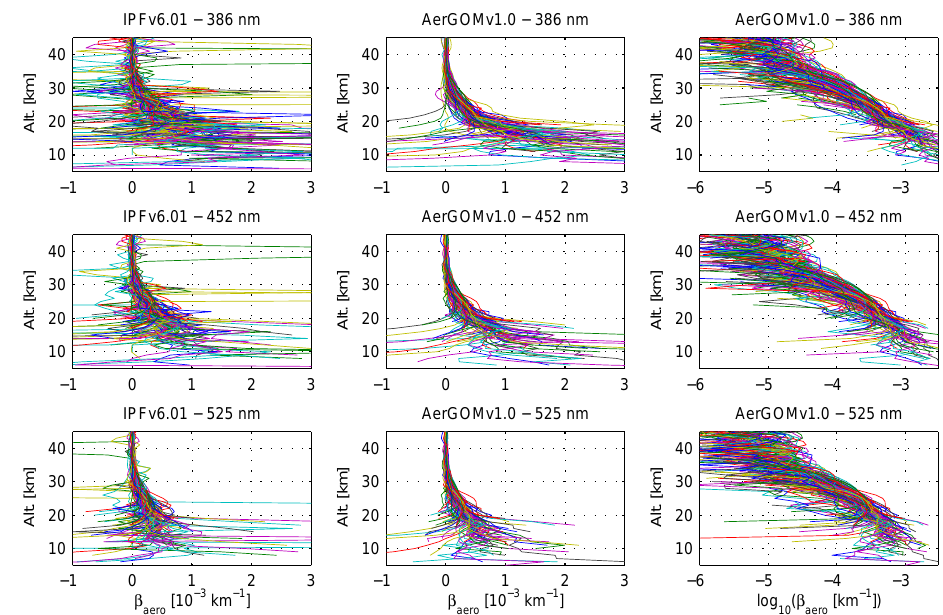
Figure 5. A set of 115 randomly chosen GOMOS aerosol extinction profiles, evaluated at three wavelengths, for the two algorithms. Left column: IPFv6.01; middle column: AerGOM v1.0. Right column: AerGOM v1.0, base 10 logarithm of aerosol extinction.